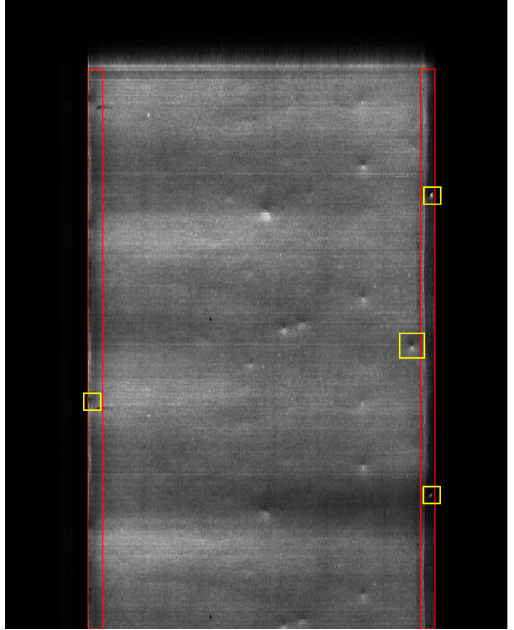
Figure 1. The red mark indicates the hard-to-detect area and the yellow mark indicates a defect that is not easily detected on the edge.